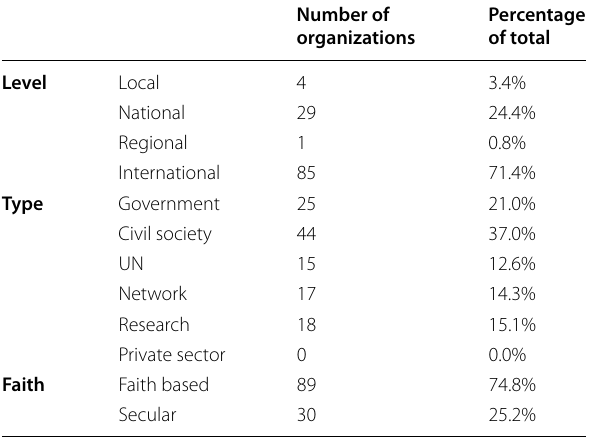
Table 2 A summary of 119 stakeholders identified by